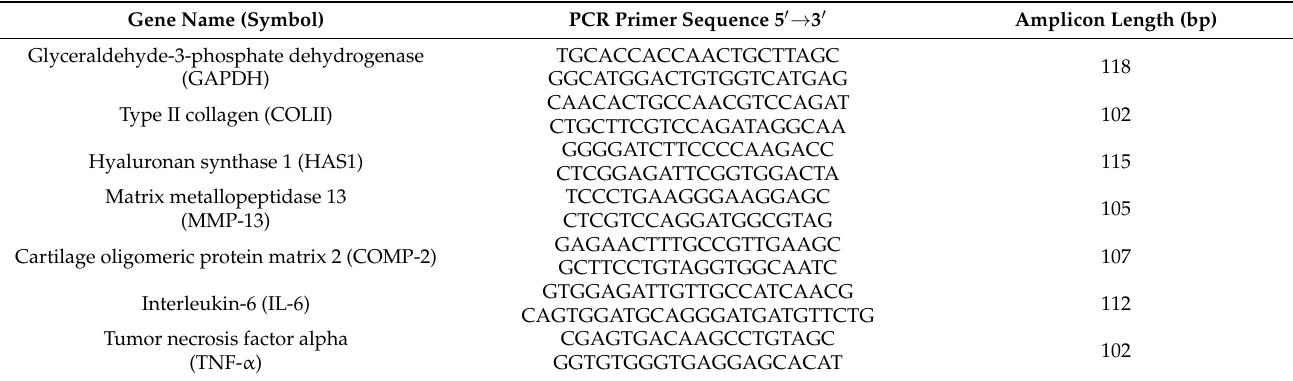
Table 2. Primer sequences used in